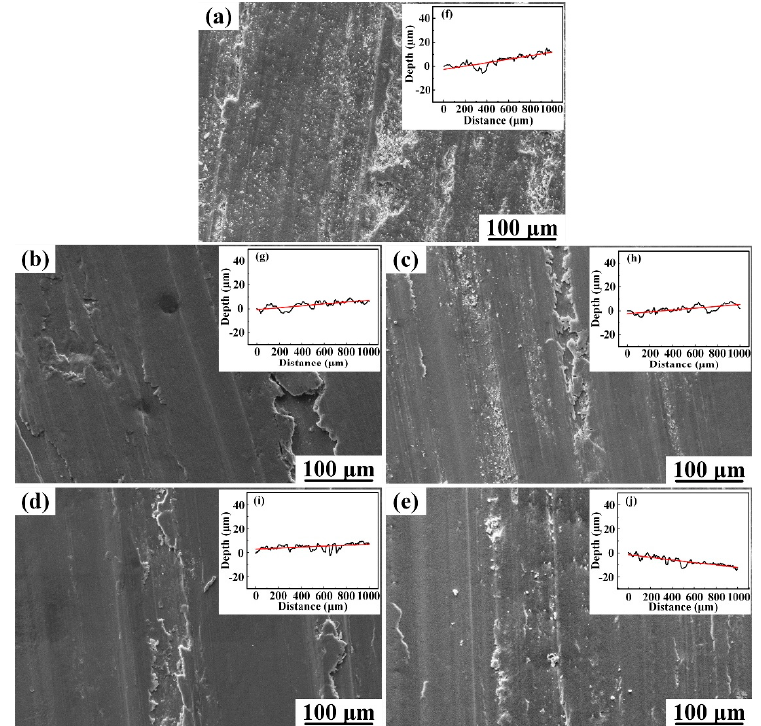
Figure 10. The worn surfaces of ( a ) the Al-Cu matrix alloy and Al-Cu matrix composites